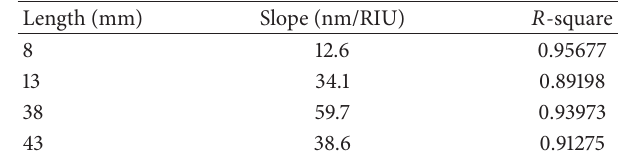
Table 5: Refractive index measurement results for the reduced 𝐿 range.